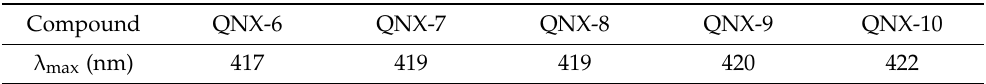
Table 5. Optical characteristics of QNX-6-QNX-10 in 1-methyl-2-pyrrolidone.